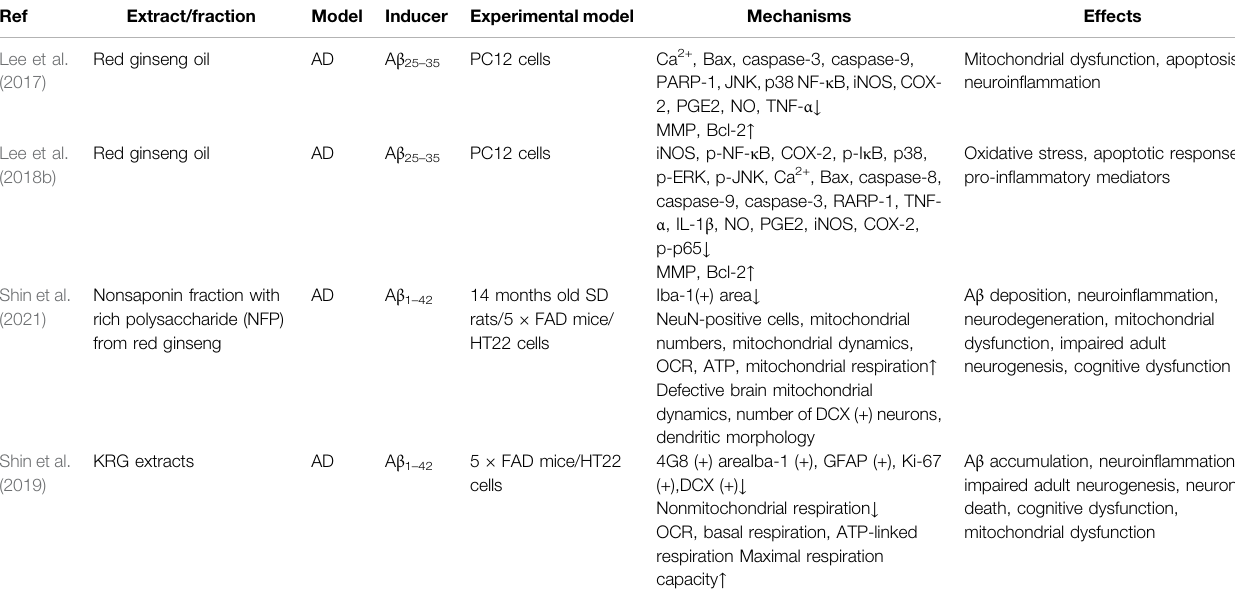
TABLE 2 | Summary of effects and mechanisms of extracts or fractions from ginseng in neuronal cells and animal models.